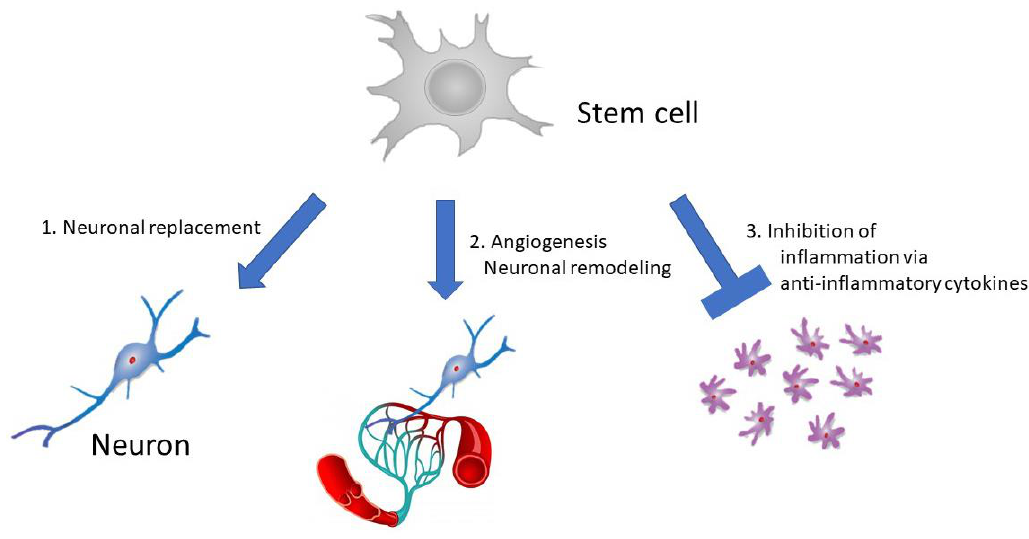
Figure 1. Schema of mechanisms of cell-based therapies for stroke.